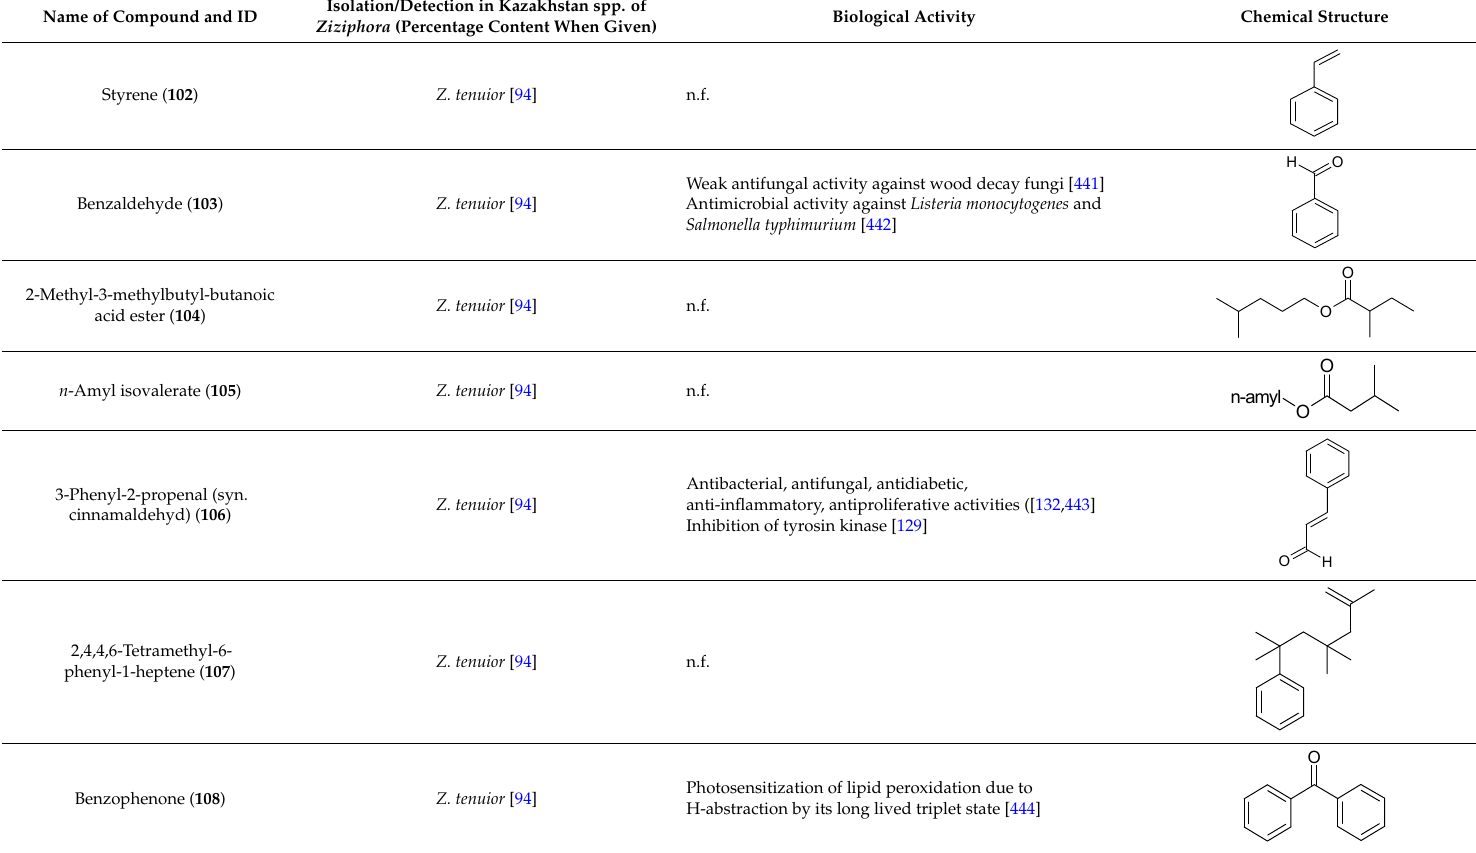
Table 4. Miscellaneous substances isolated from Kazakhstan Ziziphora species (N.f.—not found).